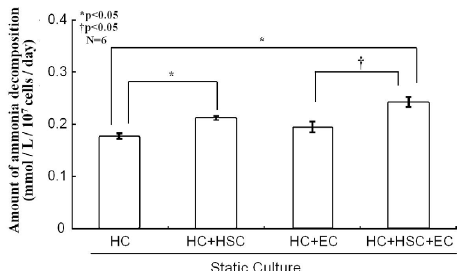
Fig. 3 Amount of ammonia decomposition in static culture when hepatocytes (HC) were co-cultured with hepatic stellate cells (HSC) and/or endothelial cells (EC). Ammonia decomposition is defined as the difference in ammonia concentration before experiment and after 24 h. An increase in ammonia decomposition was observed in the HC+HSC and HC+HSC+EC models. Data are presented as the means